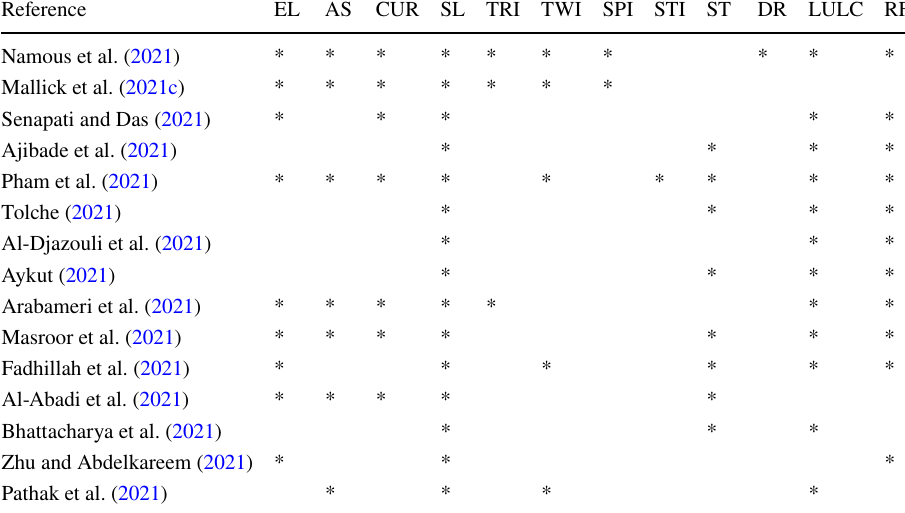
for groundwater potentiality conditioning parameters